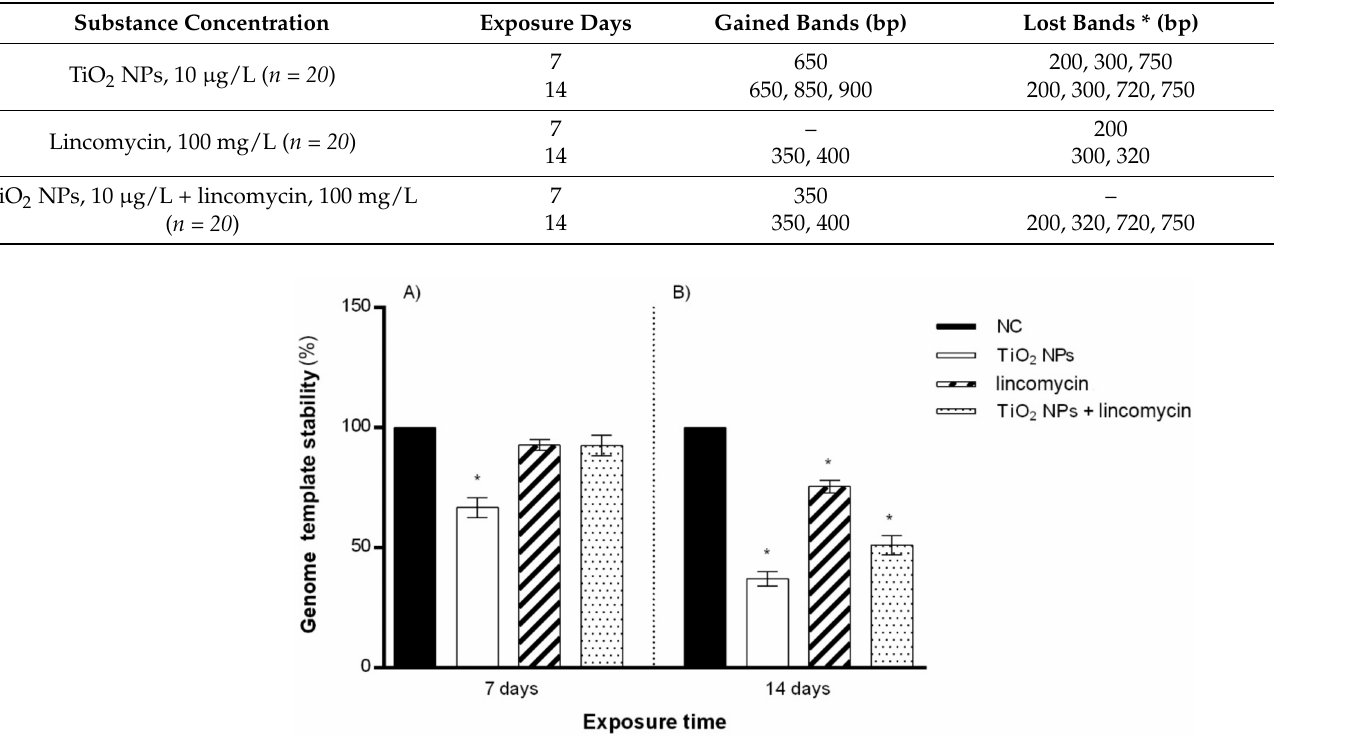
Figure 5. Percentage of genomic template stability (GTS%) in the zebrafish genome (ordinate) after 7 days of exposure ( A ) and after 14 days of exposure ( B ) to TiO 2 NPs alone, lincomycin alone, and TiO 2 NPs and lincomycin in combination (abscissa). The dark bars are the negative control (NC); the white bars are 10 µ g/L TiO 2 NPs treated specimens (TiO 2 NPs); the striped bars are 100 mg/L lincomycin treated specimens (lincomycin); and the dotted bars are 10 µ g/L TiO 2 NPs + 100 mg/L lincomycin treated specimens (TiO 2 NPs + lincomycin); * p ≤ 0.05 in comparison with the